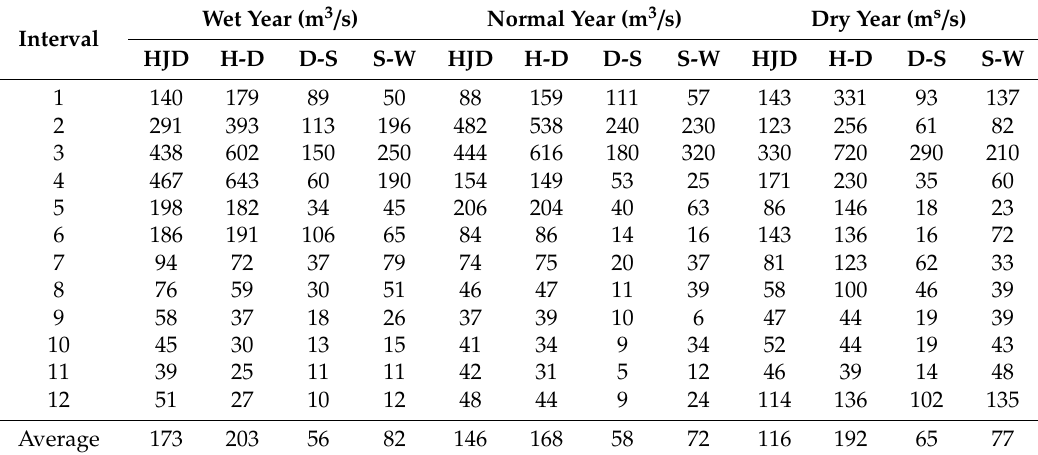
Table 2. Inflow to reservoir for di ff erent climate